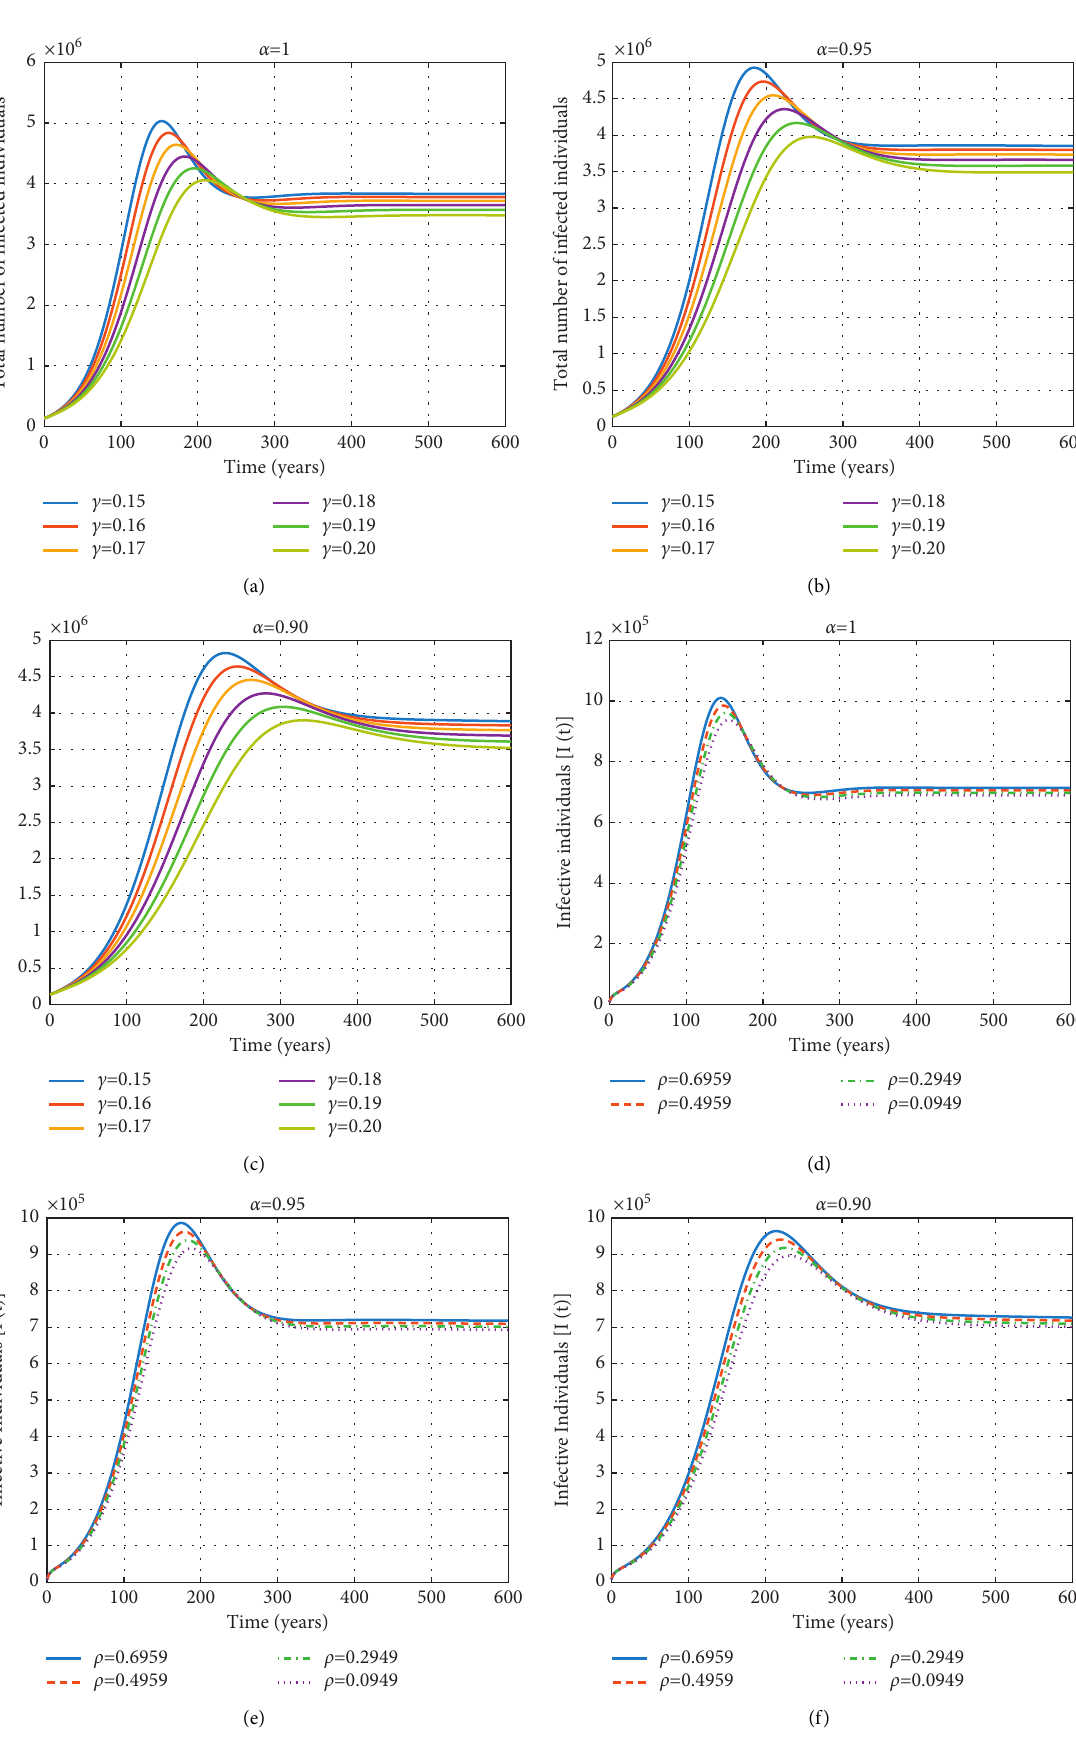
Figure 6: The treatment rate c impact on cumulative infected persons (a–c) and variation of ρ on infectious individuals (d–f) for α � 1 , α � 0 . 95, and α � 0 .